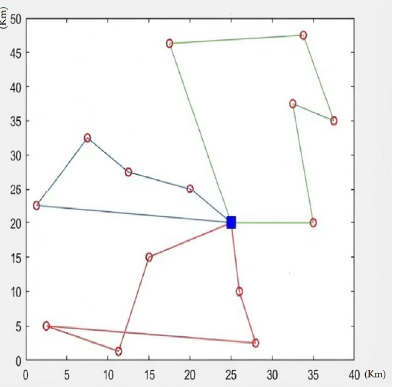
Figure 5. Traditional genetic algorithm distribution route.